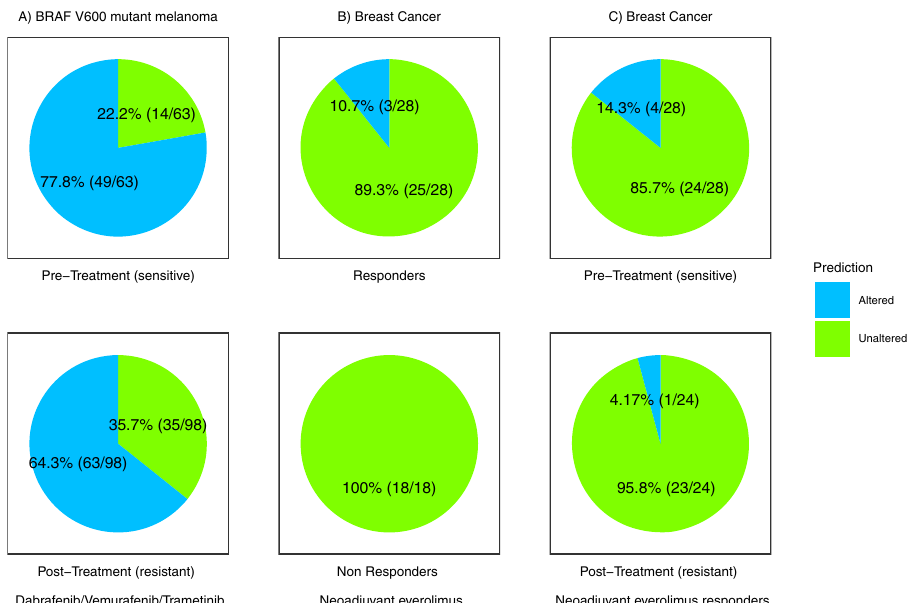
Fig. 6 Clinical validation of phenocopy signatures. Our BRAF and mTOR phenocopy signatures were applied to BRAF-mutant melanoma ( A ) and breast cancer cohorts ( B , C ), respectively. Altered or unaltered status indicates the alteration status assigned by the BRAF/mTOR phenocopy signatures. Pre-treatment samples were considered sensitive, and post-treatment samples were considered resistant per the original